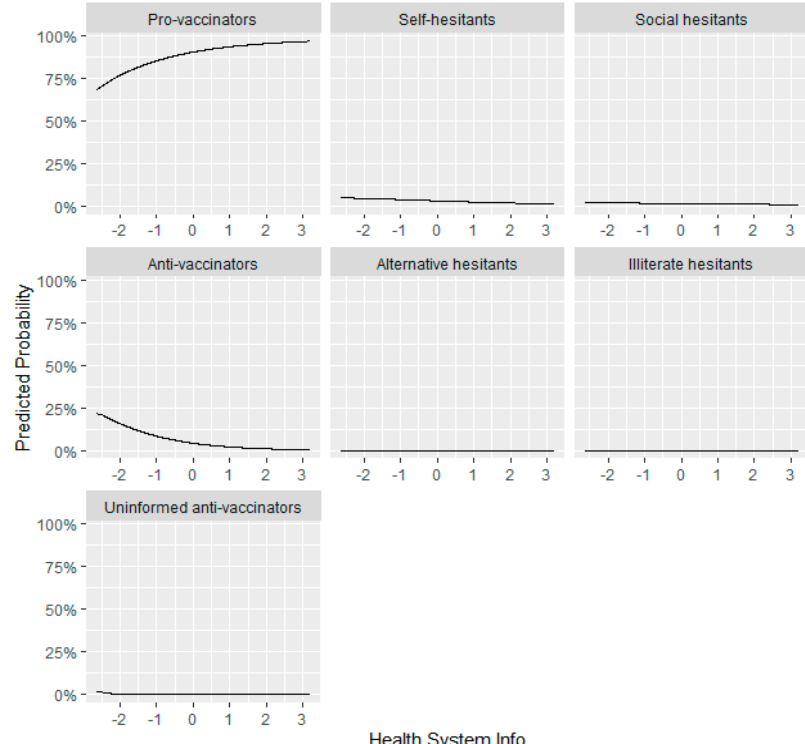
Figure A12. Marginal Effects Multinomial Logistic Regression. Health System